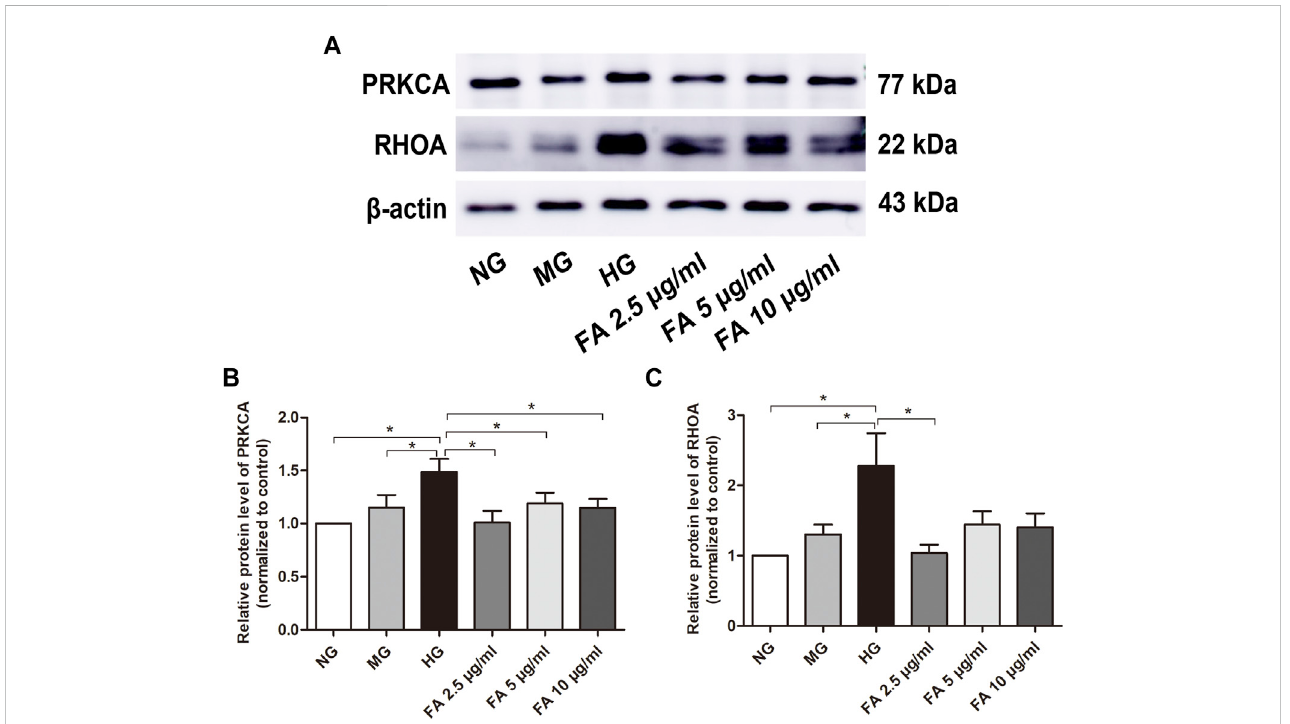
FIGURE 9 Examination of PRKCA and RHOA protein expression levels after Forsythiaside treatment. (A) The protein levels of PRKCA and RHOA in podocytes were examined by Western blotting. (B) Quanti fi cation of PRKCA protein expression in podocytes after various treatments. (C) Quanti fi cation of RHOA protein expression in podocytes after different treatments. Values are expressed as mean ± S.E.M. * p < .05. NG: normal glucose; MG: isosmotic mannitol; HG: high glucose; FA: